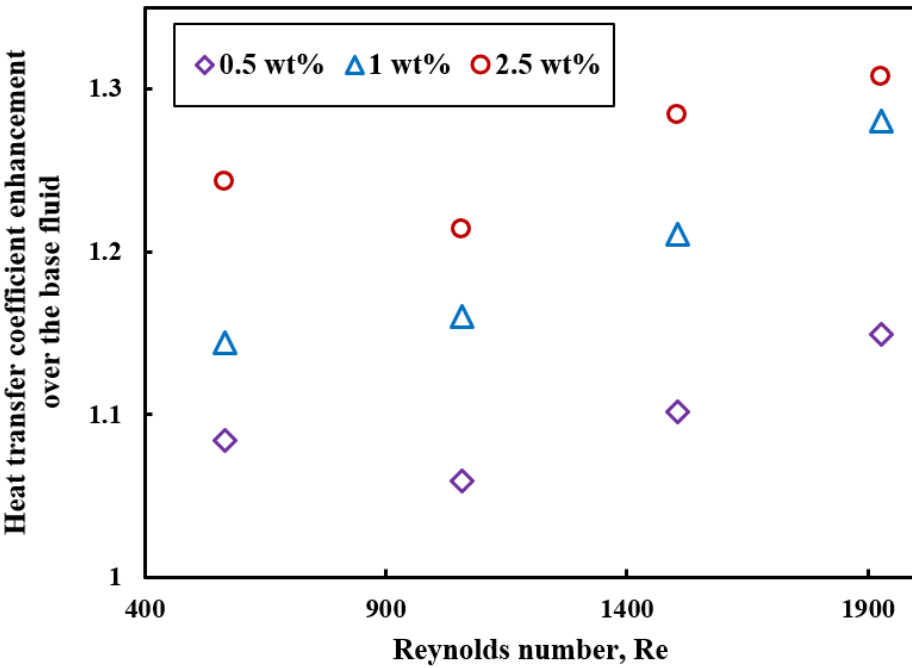
Figure 23. Forced convective heat transfer coefficient enhancement of ILs based nanofluids as a function of Reynolds number (x/d = 75.65) in laminar flow regime [49]. Reproduced with permission from [Paul], [Int. J. Heat Mass Transf.]; published by [Elsevier], 2015.